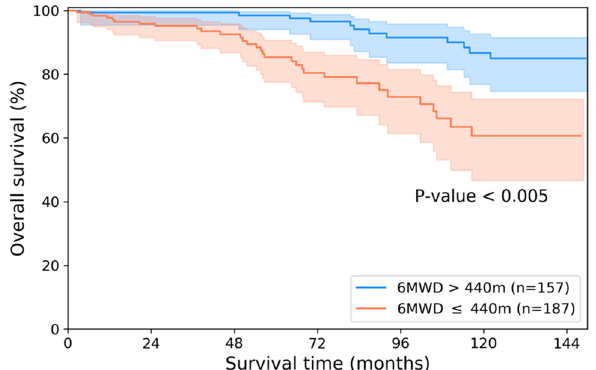
Figure 1. Kaplan–Meier survival curves for patients with 6MWD over and less than 440 m in discovery cohorts. We designed and trained a CNN-based binary classifier to obtain high-level representative information from chest CT that can predict mortality in patients with COPD. This CNN-based binary classifier was based on the 6MWD testing results, and the discovery cohort was divided into two groups with the value of 440